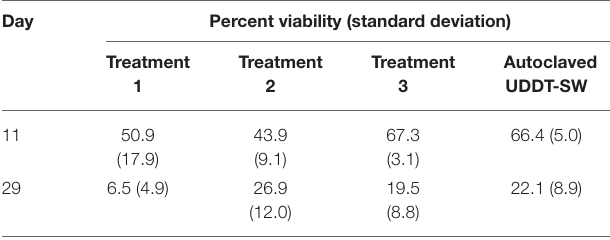
TABLE 4 | Average percent viability of Ascaris eggs collected for field-scale trial during Experiment